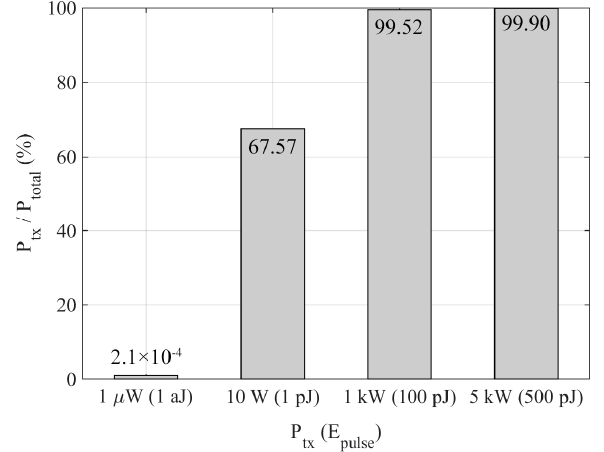
Figure 1. Relation between power required for communication and the total power consumption for different transmission powers.